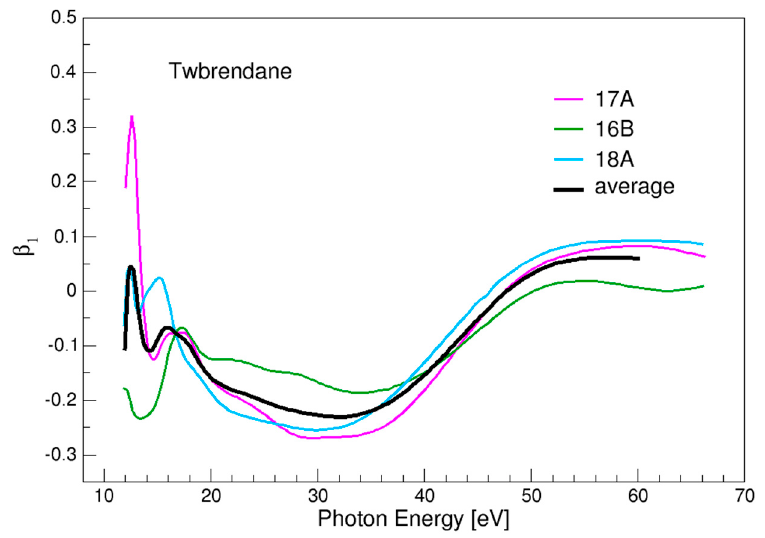
Figure 7. β 1 parameter for the three outermost ionizations, 17A, 16B and 18A, and the average value, in twistbrendane.